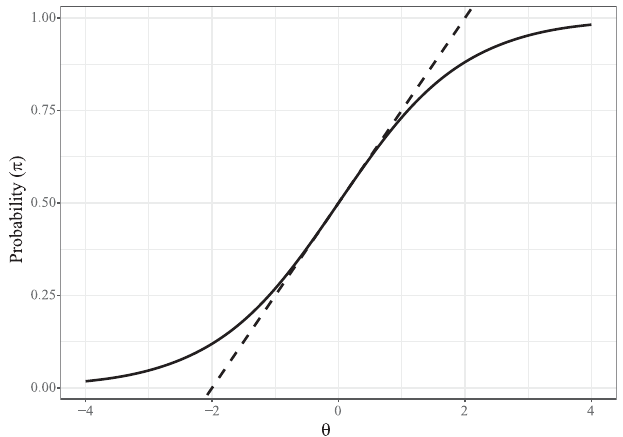
FIG. 1. Probability of selecting the correct response, π ð θ Þ , versus ability θ using d ¼ 0 and a ¼ 1 . The dashed line represents the slope at θ ¼ 0 and has slope a= 4 ¼ 0 . 25